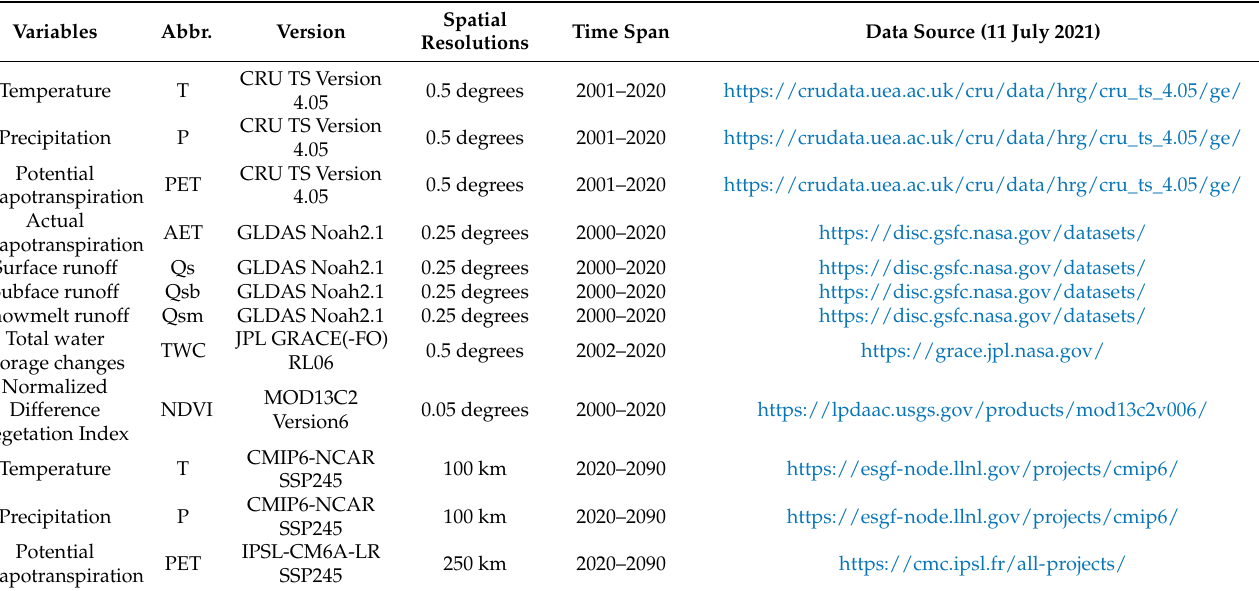
Table 1. Summary of the dataset applied in this